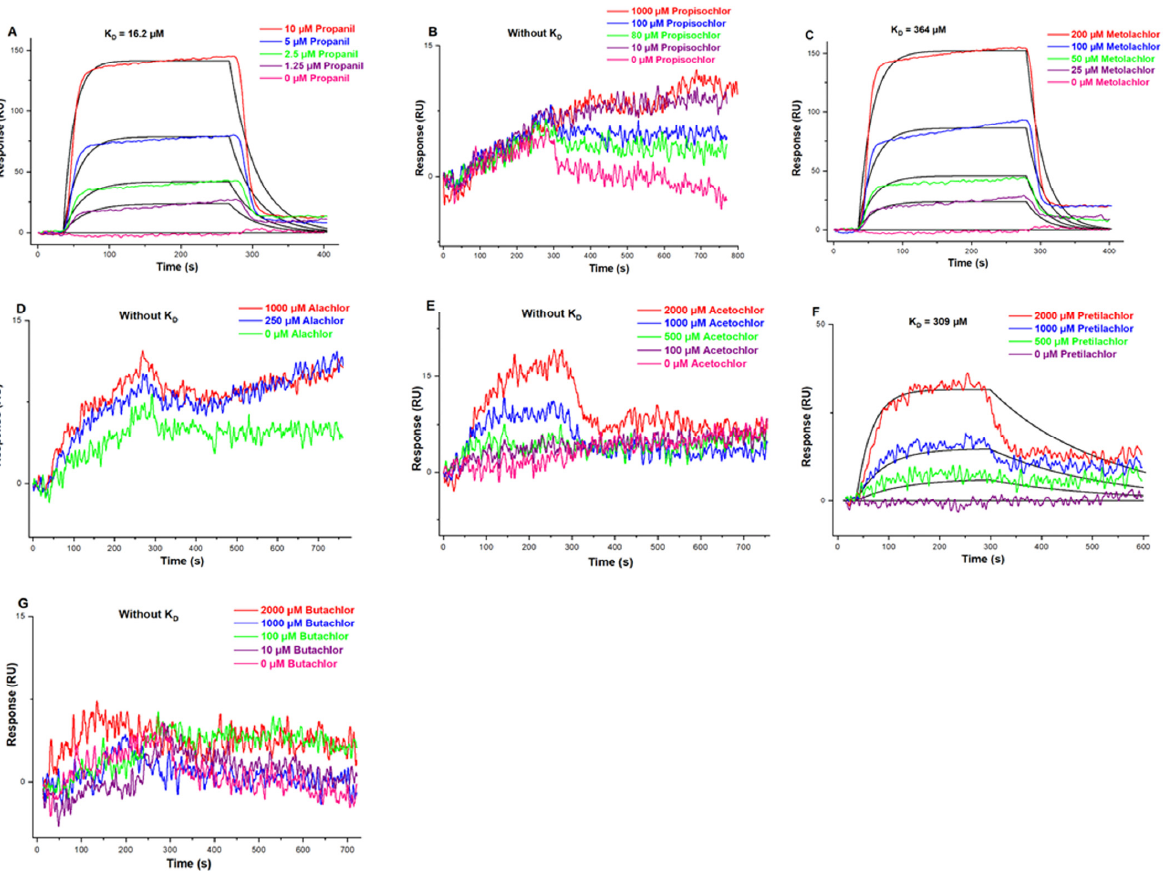
Figure 4. Affinity curves and constants of hTRPA1 and AHs. ( A ) Propanil, ( B ) Propisochlor, ( C ) Metolachlor, ( D ) Alachlor, ( E ) Acetochlor, ( F ) Pretilachlor, ( G ) Butachlor. K D : affinity constant.